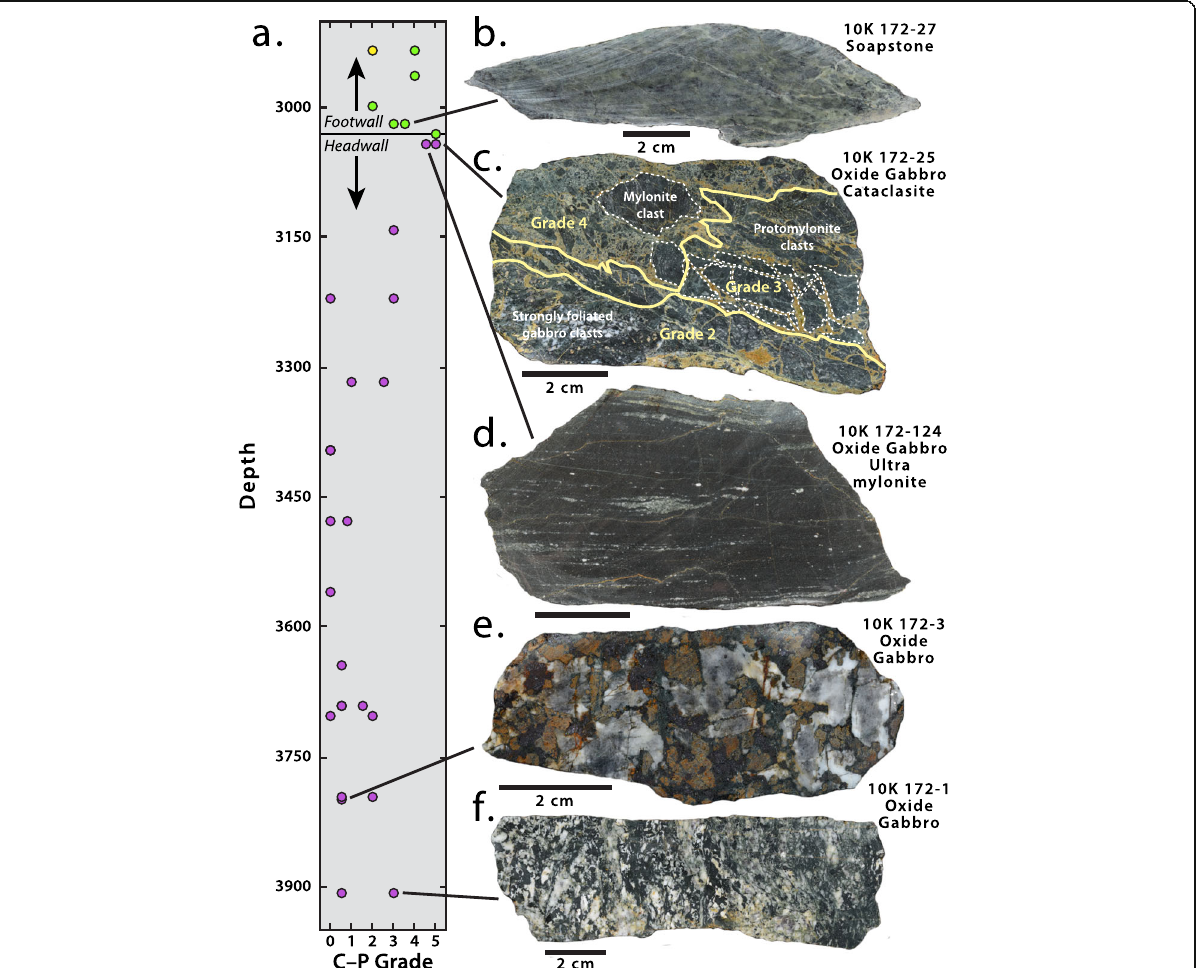
Fig. 36 Representative samples from Kaiko Dive 172 (Fig. 35) showing different crystal-plastic (C-P) deformation grades and lithologies in the fault damage zone overlying massive oxide gabbro. a Crystal-plastic deformation grade versus depth. Solid line separates samples collected from the landslip scar headwall, and lower transform wall from those collected on the gently sloping intact detachment fault footwall. b Lenticular shear polyhedron or phacoid of soapstone. c Oxide gabbro cataclasite grading upward from a Grade 2 brecciated and foliated gabbro, to Grade 3 protocataclasite, and to a Grade 4 cataclasite, all cemented by epidote. Matrix is finely comminuted gabbro and epidote. Solid yellow lines separate brittle deformation zones, and dashed white lines outline mylonite and protomylonite clasts. d Oxide gabbro ultramylonite immediately below the cataclasite. e Representative oxide gabbro with intact magmatic texture. f Oxide gabbro protomylonite pseudomorphed by albite